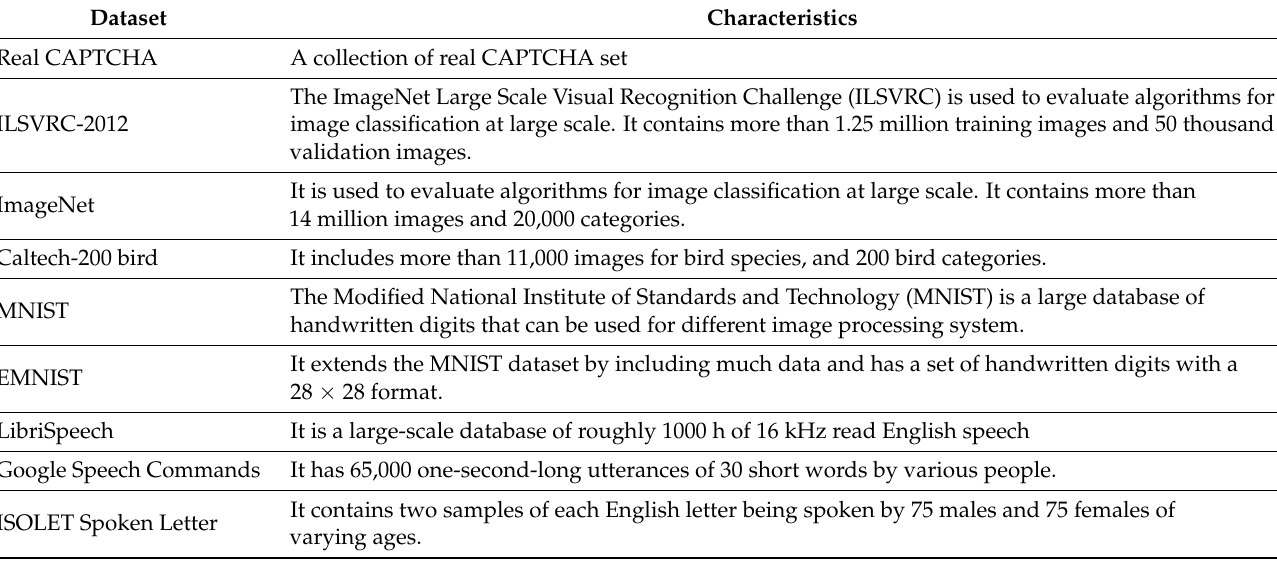
Table 4. Characteristics of used